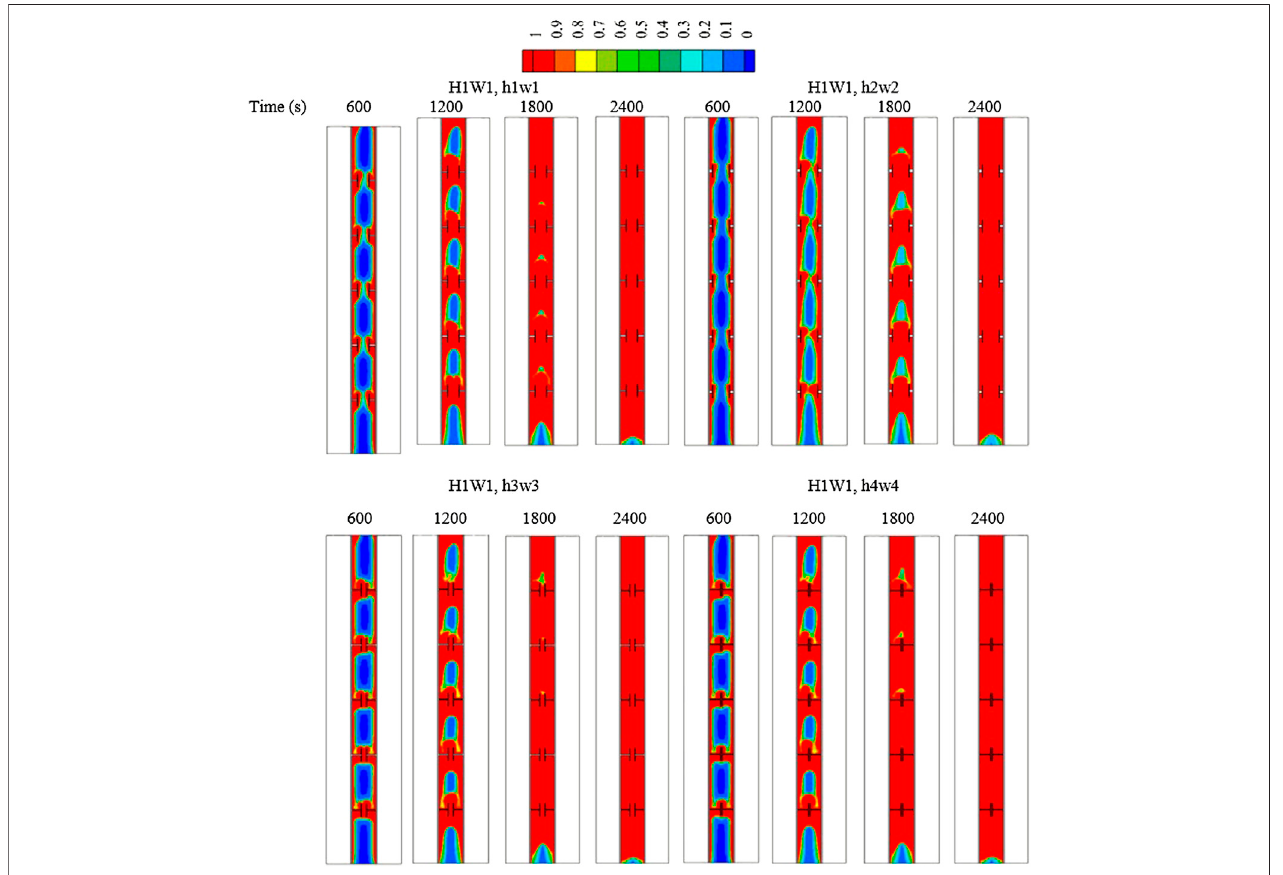
FIGURE 8 | The liquid fraction development for various dimensions of the T-shaped fi n ’ s body at various times [with the same size of the fi n ’ s head (H1, W1)].